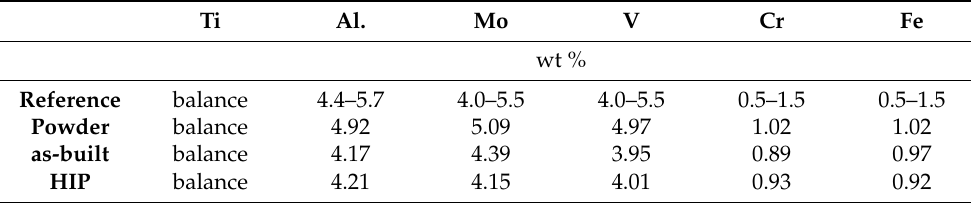
Table 3. The chemical composition of the Ti-55511, XRF